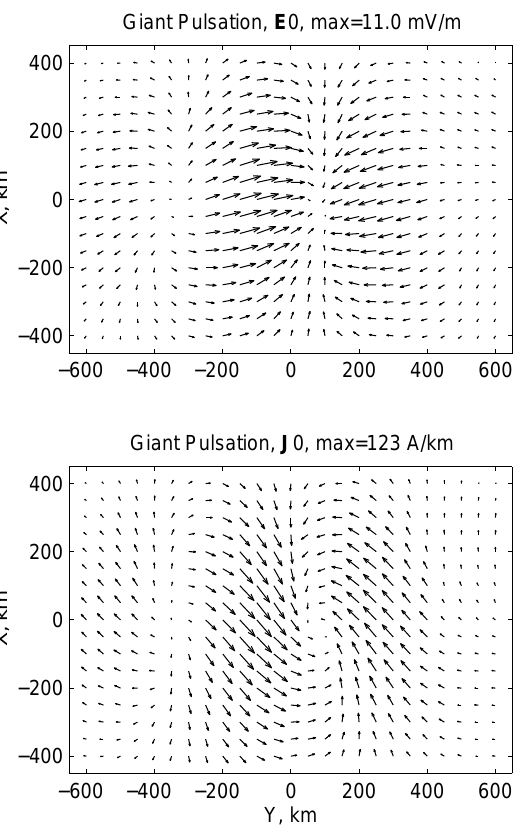
Fig. 4. Snapshot of the driving electric field and associated currents producing Giant